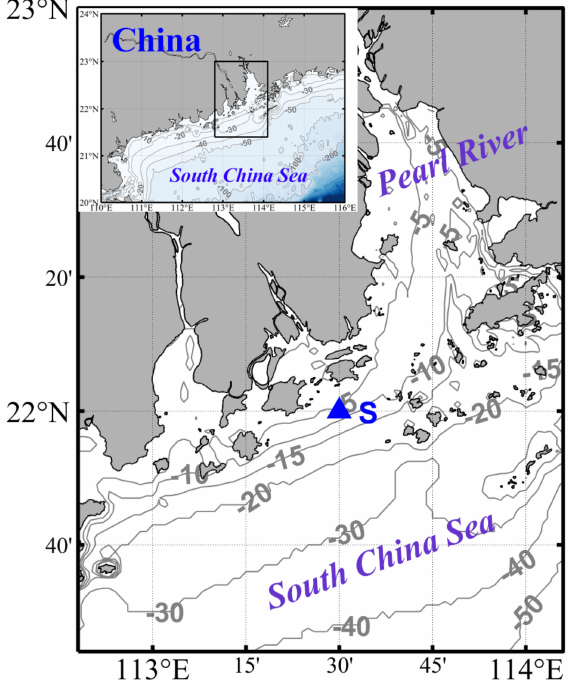
Figure 1. Bathymetry of Pearl River and adjacent coastal region. Gray contours indicate isobaths (in meter). A tide gauge site is marked by bule solid triangle. Area map is shown in upper-left